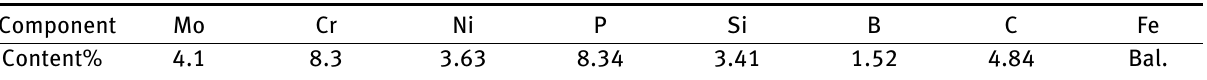
Table 1: Composition of the spraying powders ( wt %) Component Mo Cr Content%